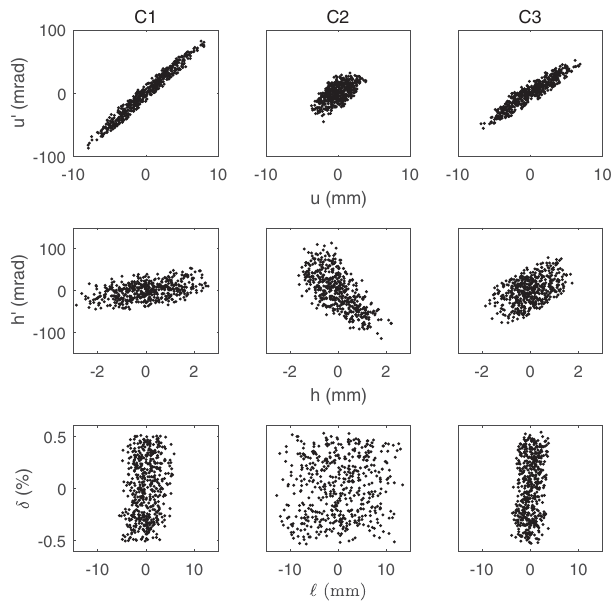
FIG. 9. Phase-space plots of the beam at the first acceleration gap for inflectors C1 (left column), C2 (middle column) and C3 (right column). The top row is vertical ð u; u 0 Þ space, the middle row is horizontal ð h; h 0 Þ space and the bottom row is longitudinal ð l ; δ Þ space. The C2-inflector has greatly improved vertical behavior compared to the original C1 inflector, but a much larger longitudinal spread. The C3 inflector has moderately improved vertical behavior compared to C1 as well as a smaller longitudinal